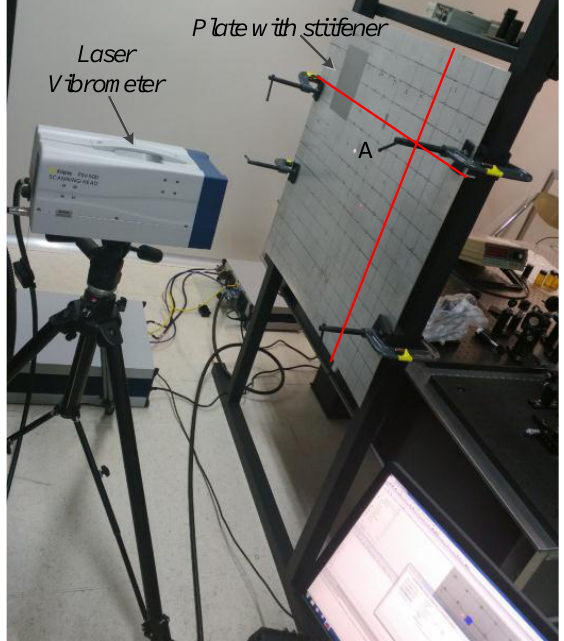
Figure 6. Experimental